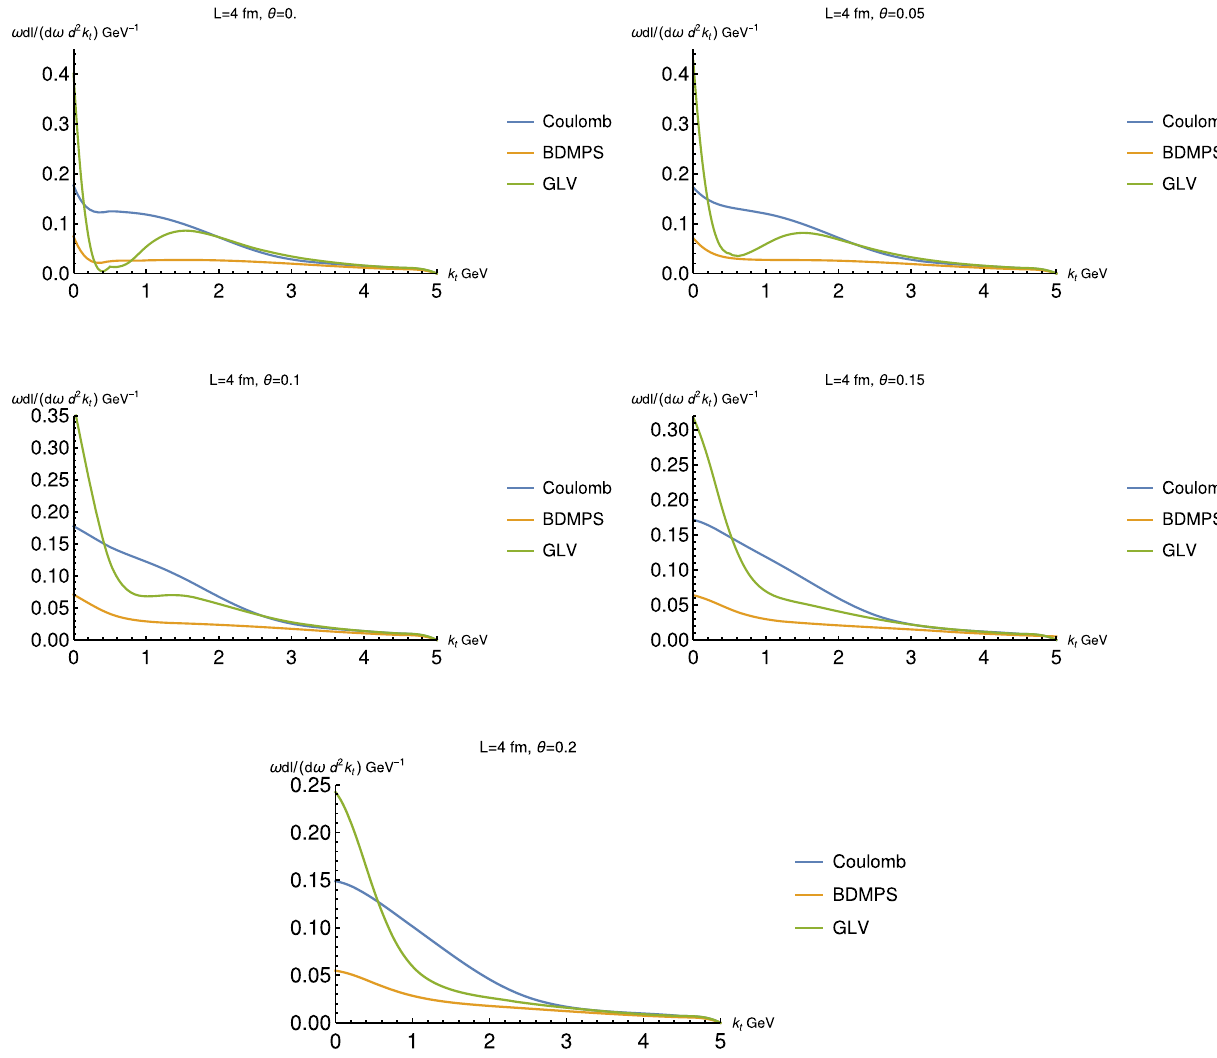
Fig. 1 The angular distribution of radiated gluons for ω = 5 GeV for different θ = 0 , 0 . 05 , 0 . 1 , 0 . 15 , 0 . 2. Here and in the Figs. 1 and 2 BDMPS means the BDMPS angular distribution in the Harmonic